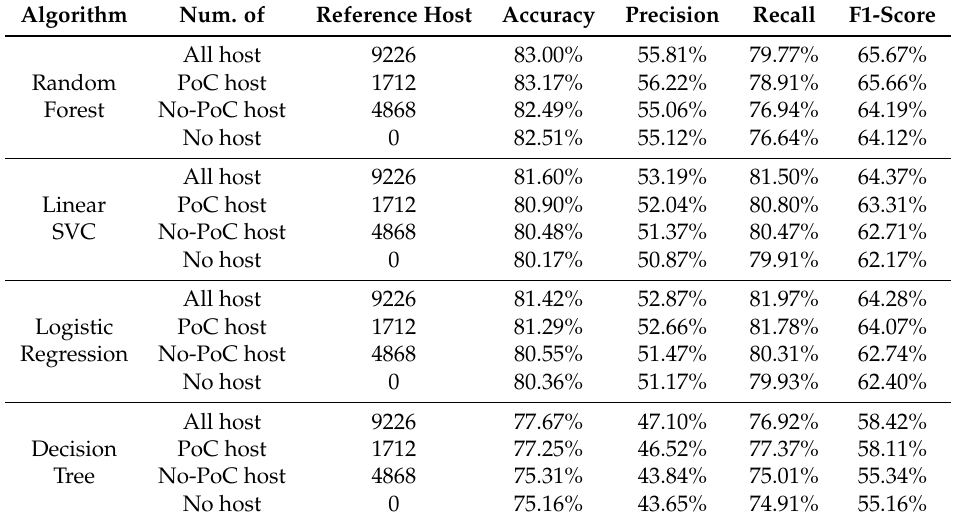
Table A1. Test set 1 results of the exploit prediction experiment based on Reference Feature.